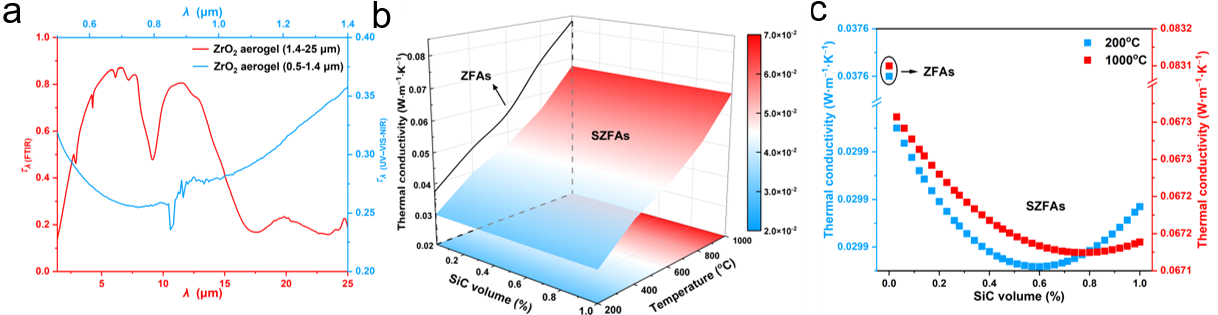
Figure 3. The radiative properties of ZFAs and SZFAs. ( a ) Spectral transmittance of the ZFAs. ( b ) Thermal conductivity of ZFAs and SZFAs. ( c ) Thermal conductivity of ZFAs and SZFAs at 200 and 1000 °C.